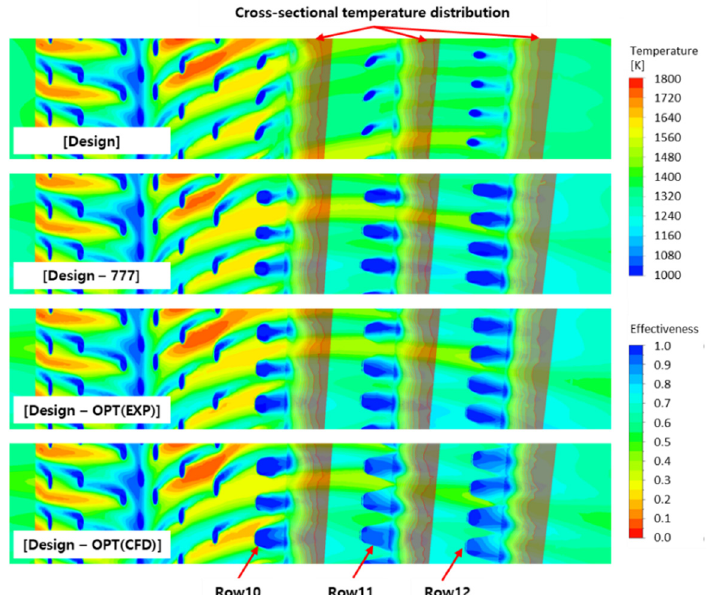
Figure 16. Cooling flow around the downstream of the cooling hole (film cooling effectiveness on the vane and cross-sectional temperature distribution).